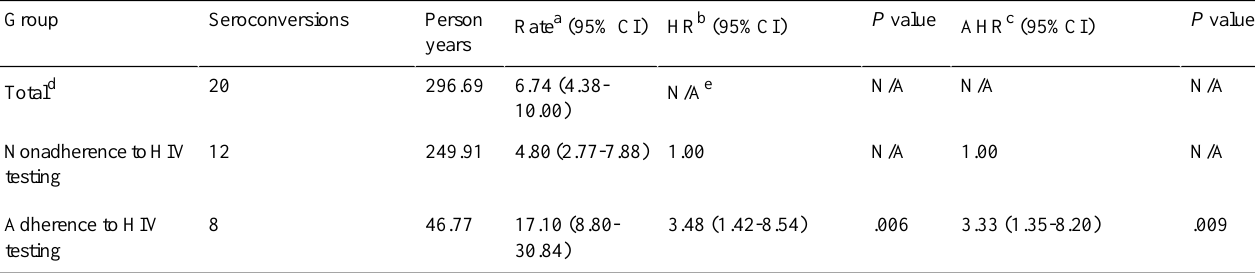
Table 3. Comparison of HIV infection rates of the adherence and nonadherence groups.